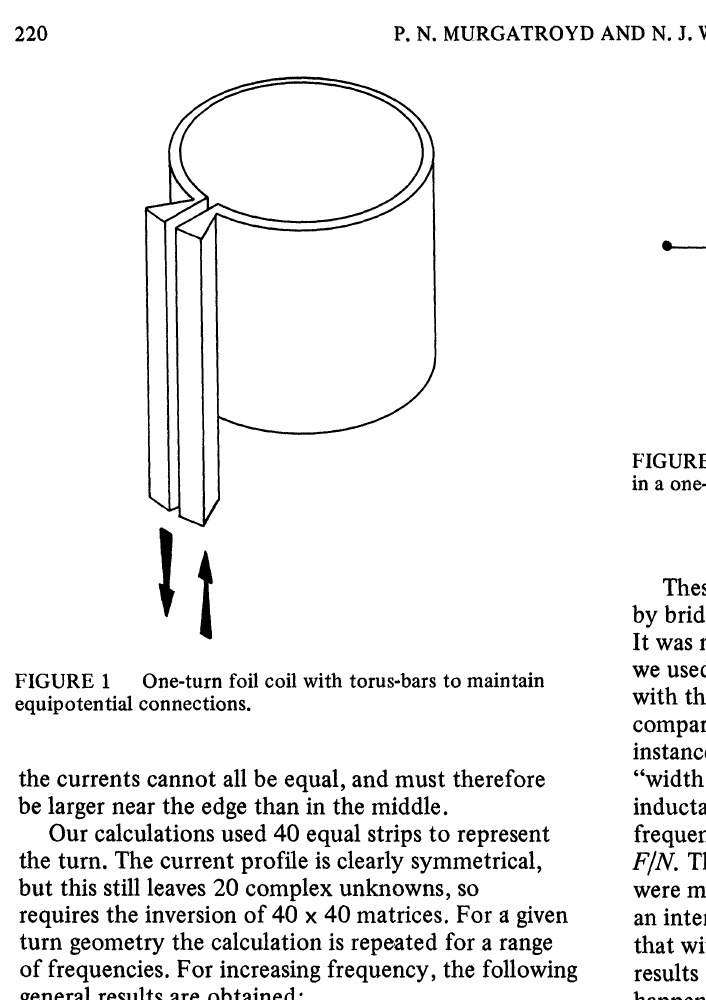
Equivalent circuit to represent "width effect" in a one-turn foil